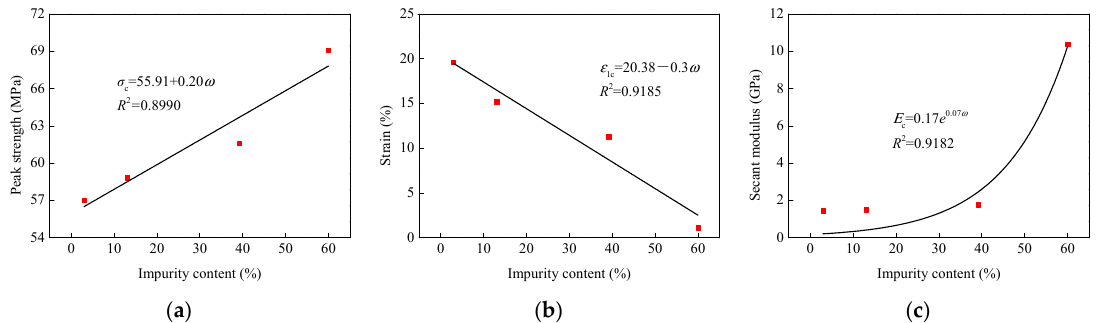
Figure 8. Mechanical parameters versus impurity content. ( a ) σ c : Peak strength; ( b ) ε 1c : Axial strain at peak stress; ( c ) E c : Secant modulus. peak stress; ( c ) E c : Secant modulus. Figure 9. Salt rock specimens after failure. ( a ) ω = 3.00% (SR-1); ( b ) ω = 13.07% (SR-2); ( c ) ω = 39.16% (SR-3); ( d ) ω = 60.02% (SR-4).